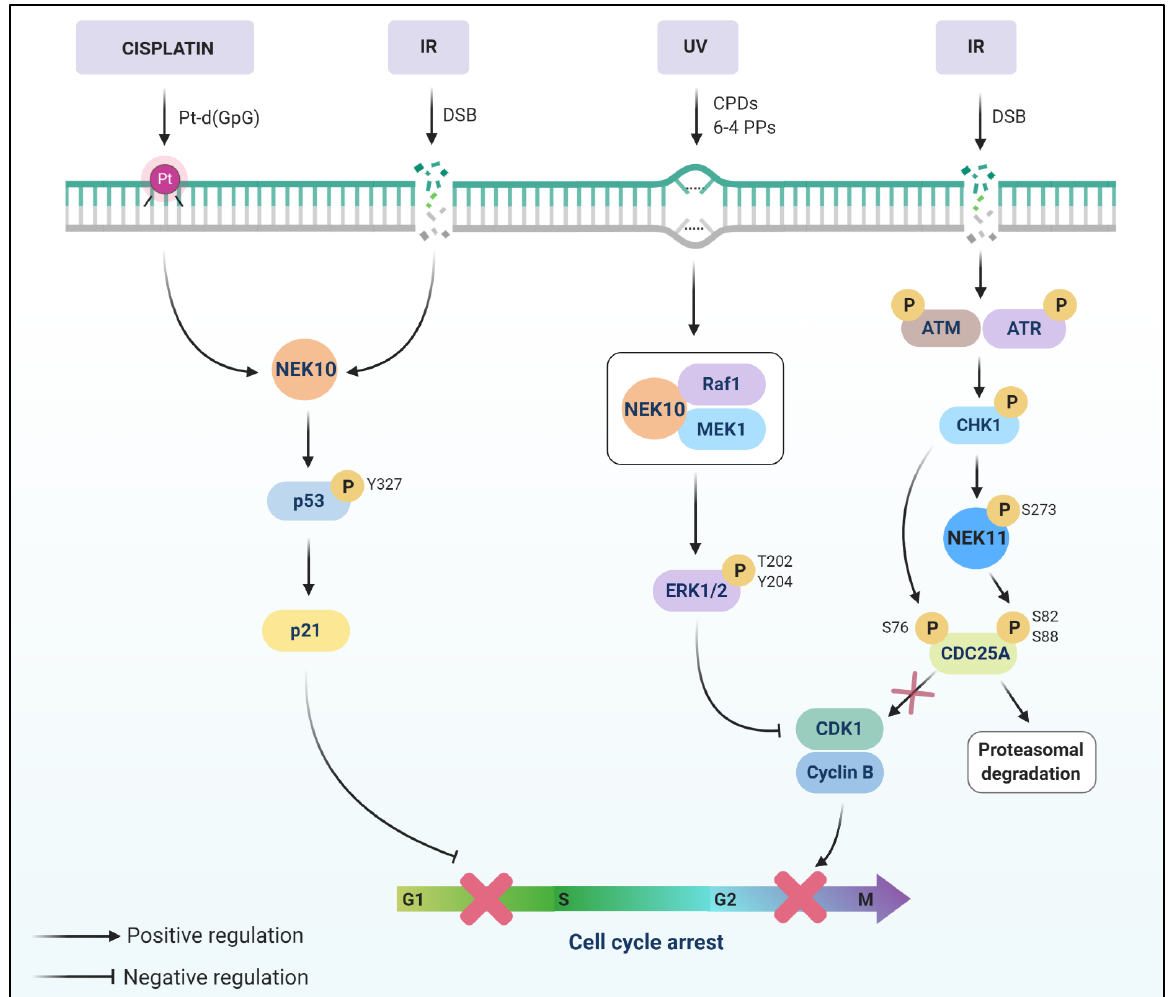
Figure 5. The signaling pathway of NEK10 and NEK11 upon DNA damage. NEK10 assembles in a ternary complex with RAF-1 and MEK1 and mediates ERK1/2 activation, playing a role in the maintenance of the G2/M checkpoint after UV light irradiation. Upon Cisplatin and IR treatments, NEK10 phosphorylates p53 at Y327, increasing p21 levels. p21 is a cyclin-dependent kinase inhibitor that suppresses the cell cycle G1/S phase. NEK10 participates in the control of cell cycle progression through p53 phosphorylation. Upon DNA damage, NEK11 is involved with ATM/ATR checkpoint pathway. Degradation of CDC25A is regulated by NEK11 through the phosphorylation of S82 and S88 of CDC25A, in vivo. CHK1 is responsible for phosphorylating NEK11 at the S273 site in vitro.